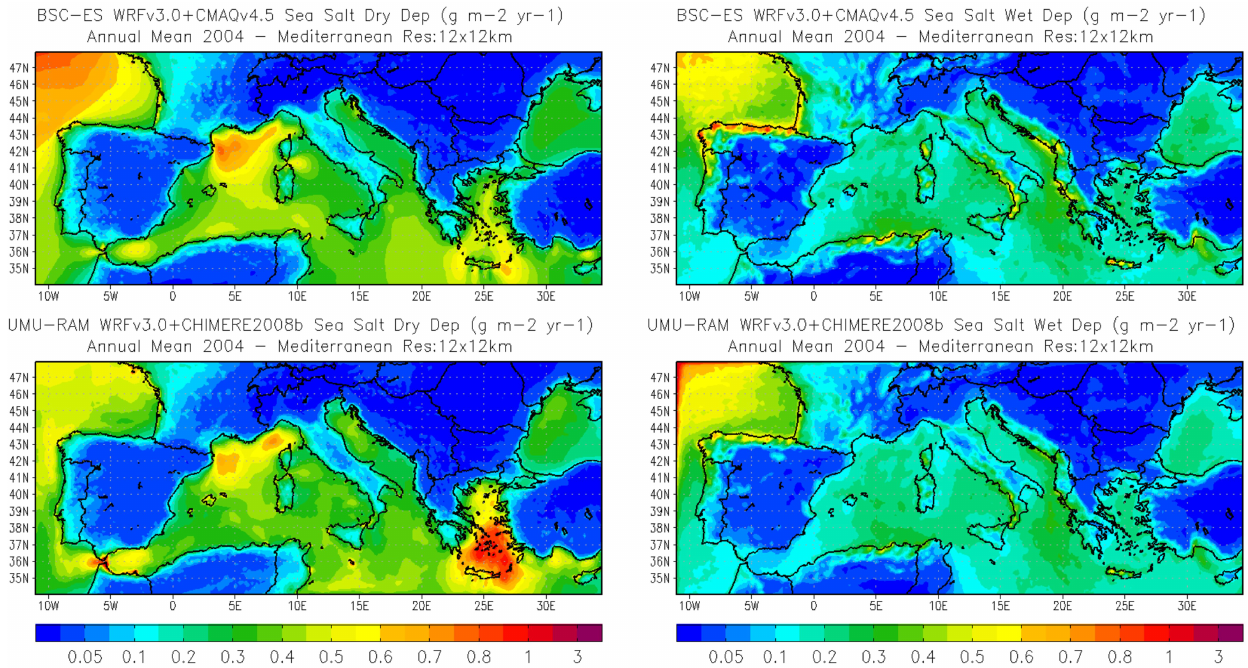
Fig. 6. Accumulated annual SSA deposition fluxes (gm − 2 yr − 1 ) for WRF + CMAQ (top) and WRF + CHIMERE (bottom) simulations: (left) dry deposition (right) wet deposition.